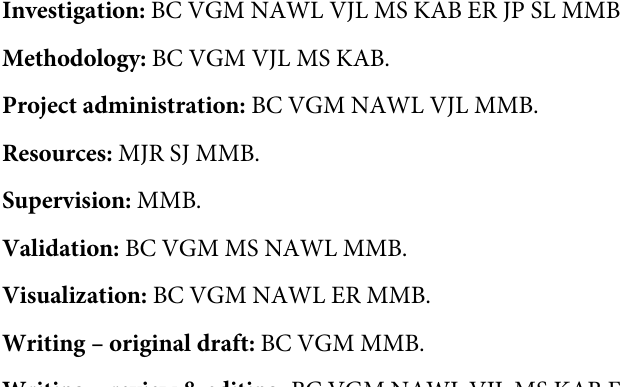
based on firefly luciferase values normalized to Renilla luciferase from stimulated samples divided by corresponding values from unstimulated samples. Data set is combined from two independent experiments and represented as mean ± SD. (TIF) S4 Fig. M35-deficient MCMV induces elevated IFN α secretion in dendritic cells compared to WT MCMV. pDC and cDC were infected with MCMV-M35stop-REV (REV) or MCMV- M35stop (M35stop) at an MOI of 0.01 (pDC), 0.1 (cDC), or left uninfected (mock). Superna- tants were harvested 16 hours p.i. for quantification of IFN α levels by ELISA. Data is shown as mean ± SD and representative of three independent experiments. (TIF) S5 Fig. M35 curtails type I IFN transcription downstream of multiple PRR. Sensing of MCMV infection by multiple PRR, including cGAS, RIG-I-like receptors (RLR), and Toll-like receptors (TLR), activates signaling cascades leading to the production of antiviral type I IFN. Upon MCMV infection, tegument M35 is rapidly transported to the nucleus in order to specif- ically interfere with NF- κ B-mediated type I IFN transcription.